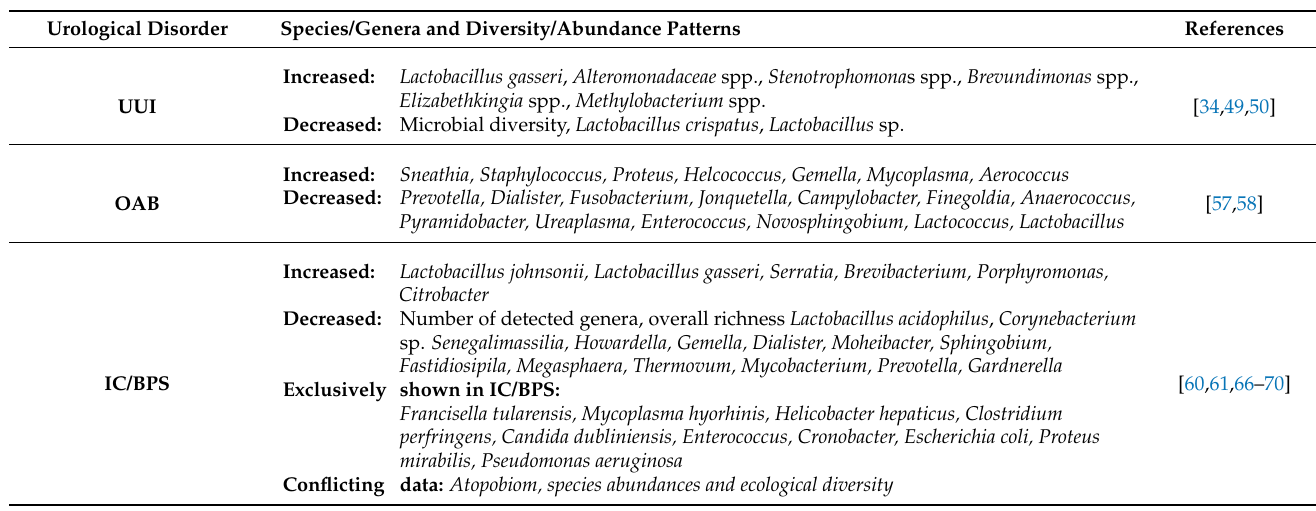
Table 1. Patterns of species, genera and/or diversity microbiome changes for UUI (urge urinary incontinence), OAB (overactive bladder) and IC/BPS (interstitial cystitis/bladder pain syndrome) as demonstrated by cited